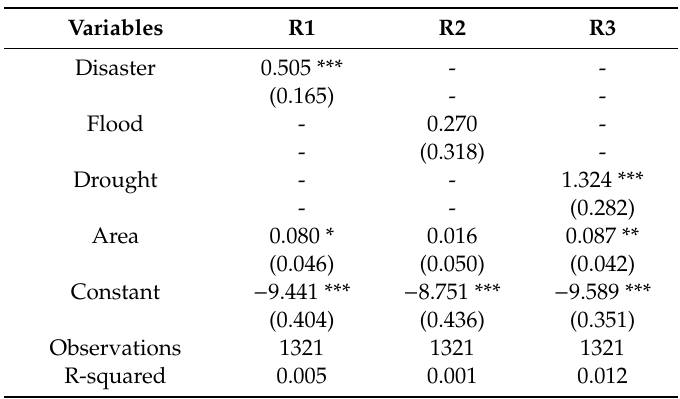
Table 3. Impact of disaster frequency on Jinshi rate, OLS